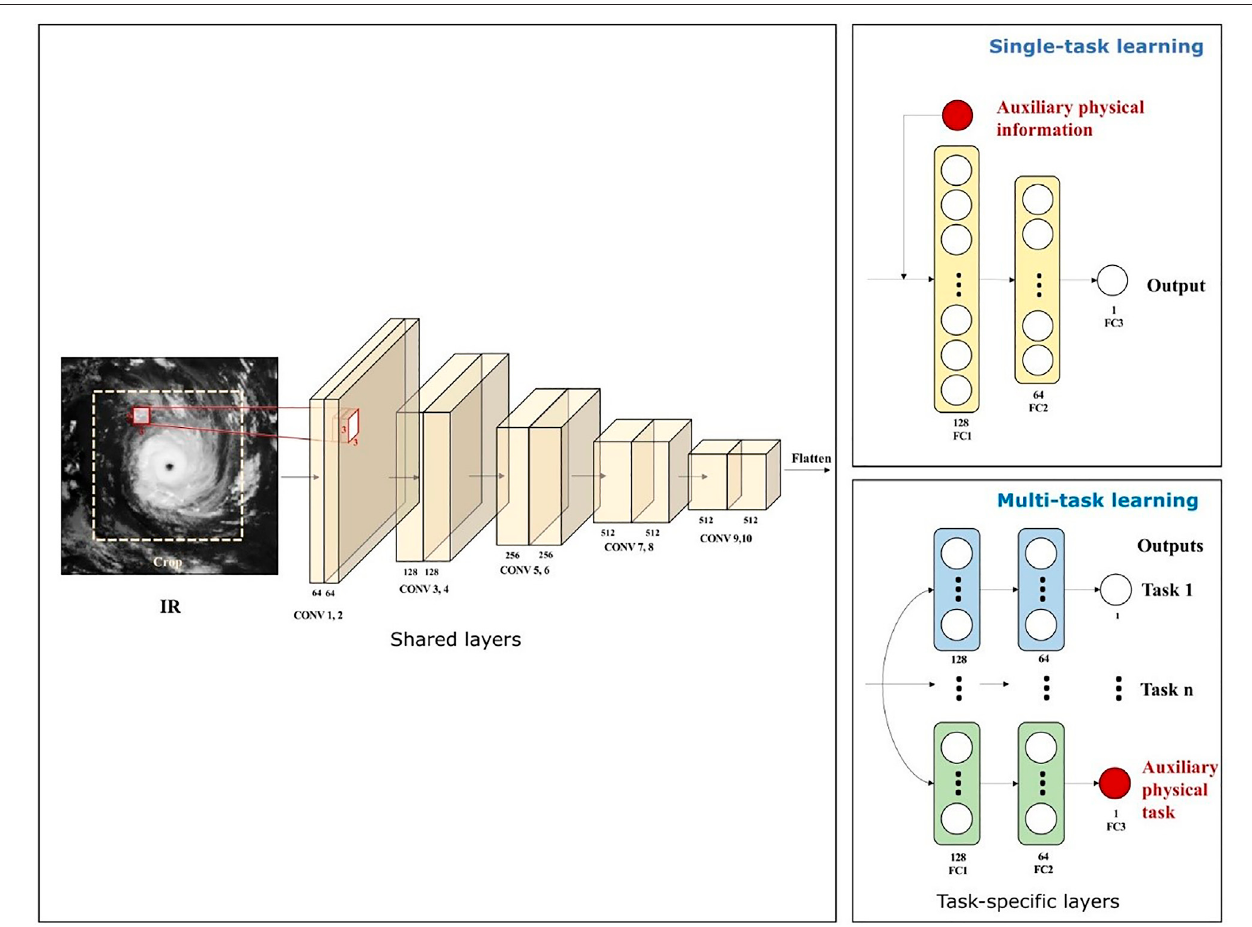
FIGURE 4 | The con fi guration of DeepTCNet in both single-task and multitask learning frameworks (Zhou and Tan, 2021).